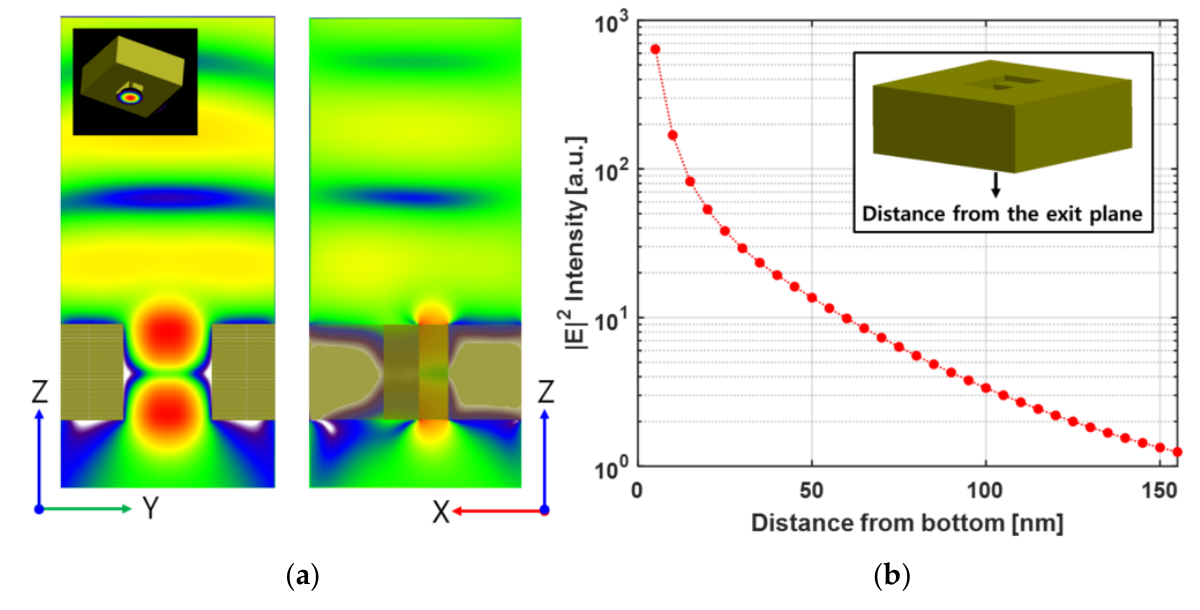
Figure 5. FDTD simulation results of the ridge-type nanoaperture: ( a ) E -field distribution in the z-y plane and x-z plane; ( b ) |𝑬| (cid:2870) intensity according to the distance from the exit plane.